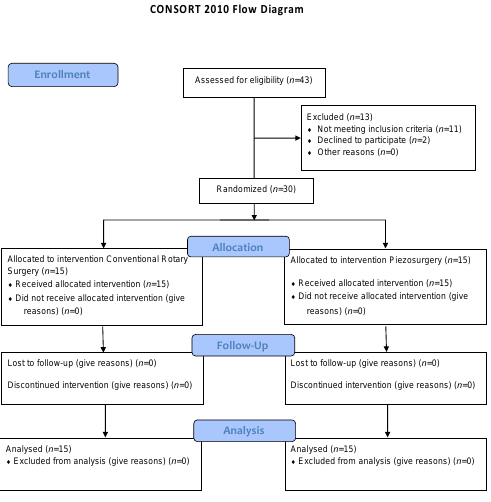
Figure 1. PRISMA flow chart.